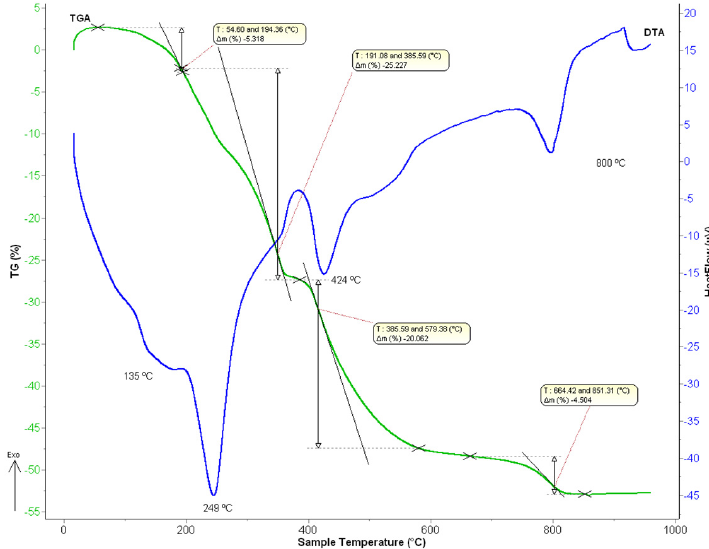
Figure 8. DTA/TGA curves of the obtained lanthanum oxalates.